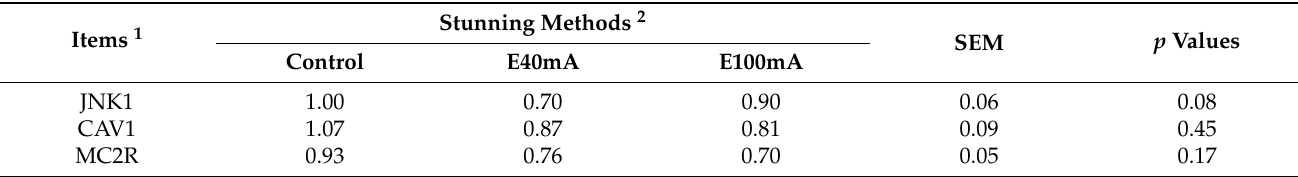
Table 5. Effect of electrical stunning (ES) methods on gene expression in the hypothalamus and pituitary.